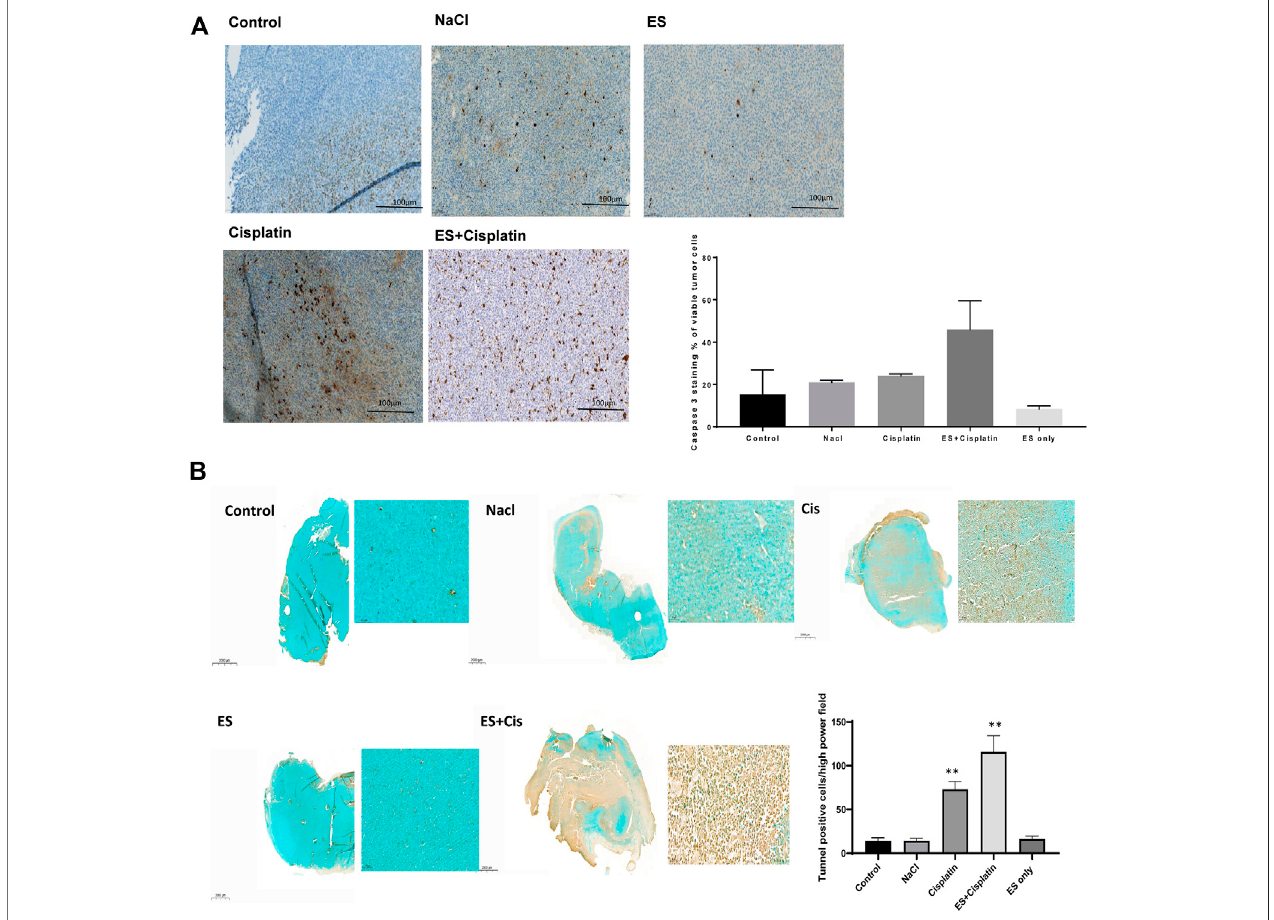
FIGURE 6 | Histological images of caspase 3 staining, and the quanti fi cation of caspase 3 positive cells (A) . Scale bar 100 µm. Images of tunnel positive cells and quanti fi cation of tunnel positive cells (B) , scale bar 2,000 µm (entire tumor) and 100 µm for inset images, data is presented as number of cells high power fi eld. Data presented as mean ± SEM, p < 0.05*, p < 0.001**, p < 0.0001 ***.